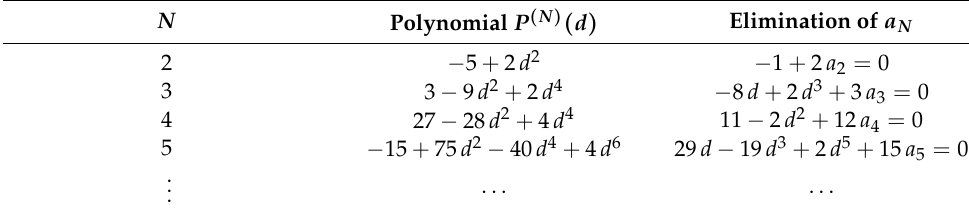
Table 1. QES even-parity values of shifts d are defined, implicitly, as zeros of polynomials P ( N ) ( d ) . A sample of the Gröbnerian elimination is added. N Polynomial P ( N ) ( d ) Elimination of a N 2